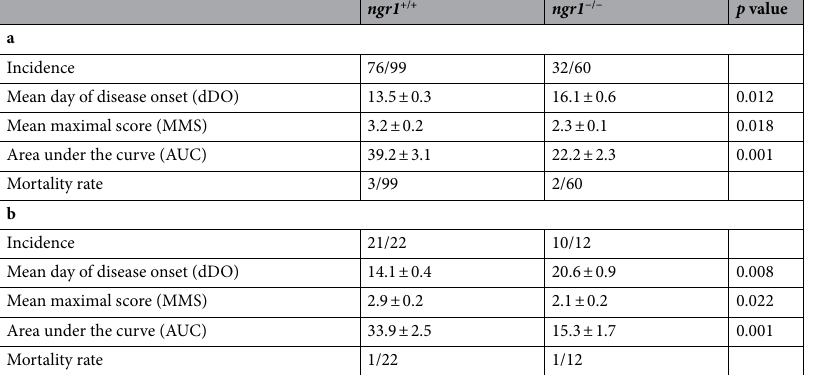
Table 1. a. Effect of ngr1 gene deletion on the clinical course in MOG 35-55 EAE. b. Effect of ngr1 gene deletion on the clinical course in rMOG EAE. a Disease parameters of the respective EAE clinical course in ngr1 +/+ and ngr1 − / − mice, as shown in Fig. 1a. Data represent mean ± SEM. b Disease parameters of the respective EAE clinical course in ngr1 +/+ and ngr1 − / − mice, as shown in Supplementary Fig. 1a. Data represent mean ±